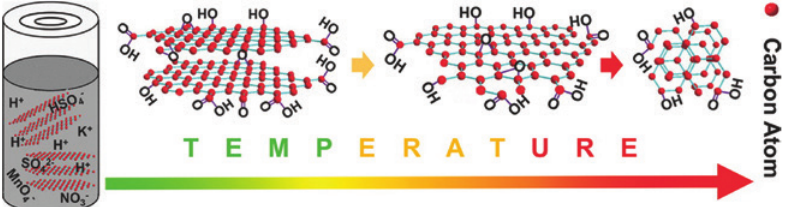
Figure 7: Schematic representation of the solvothermal reaction route, which involves exfoliating graphite to GO and further cutting of GO layers to GOQDs at given experimental conditions (reprinted/reproduced with the permission of Ref. [82], copyright 2017, Wiley-VCH Verlag GmbH & Co).